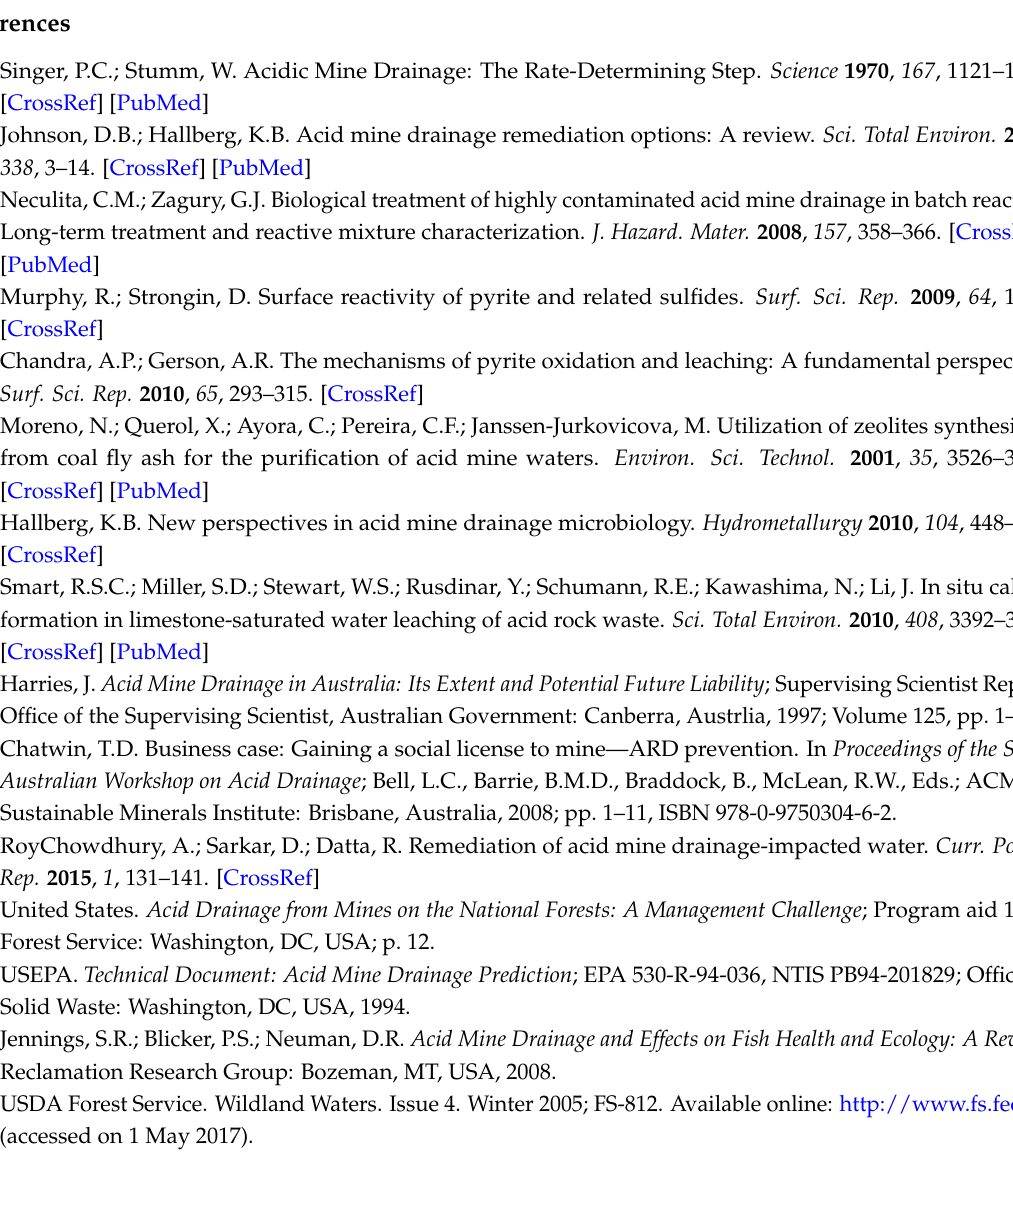
Table S1: Bulk assay results (wt %) of KLC minerals and calcite; Table S2: Biosolids leachates assay results (mg · L − 1